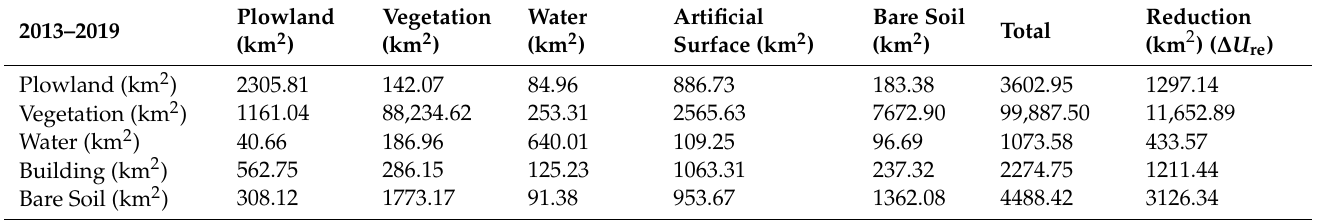
Table 4. Matrix of the land change and transfer in the water source of Danjiangkou Reservoir in